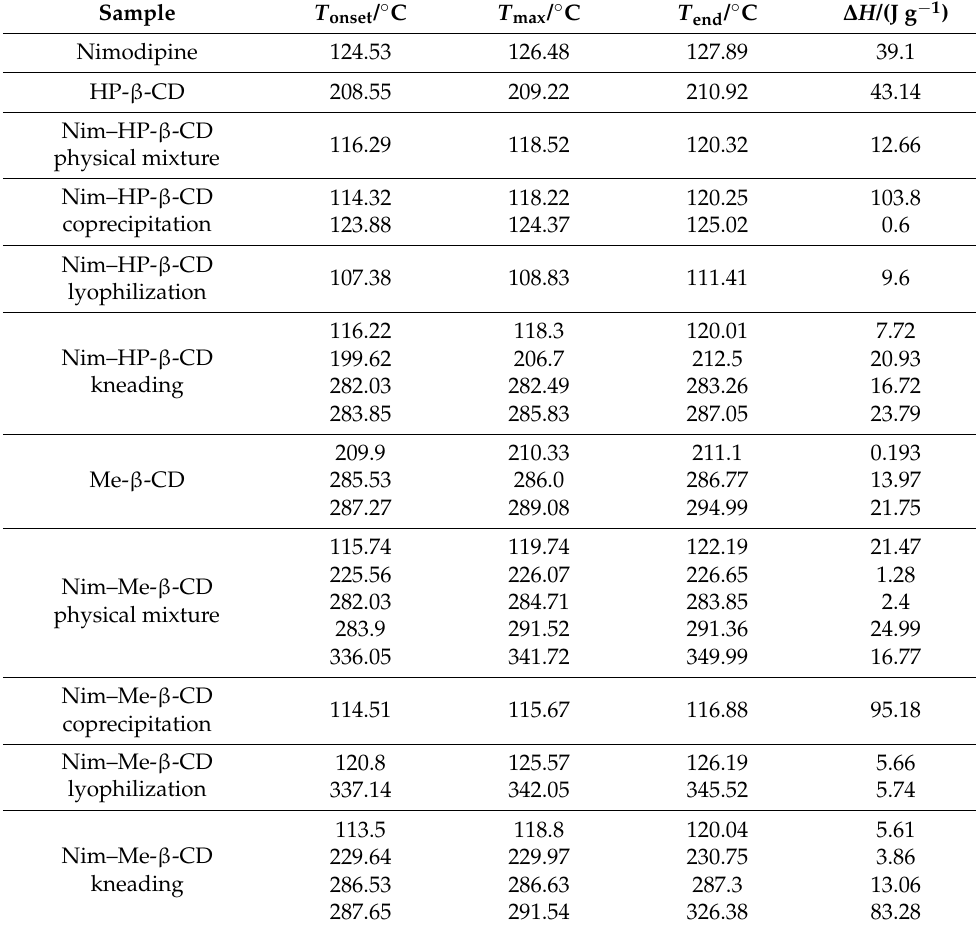
Table 3. Thermodynamic parameters for process of samples from DSC